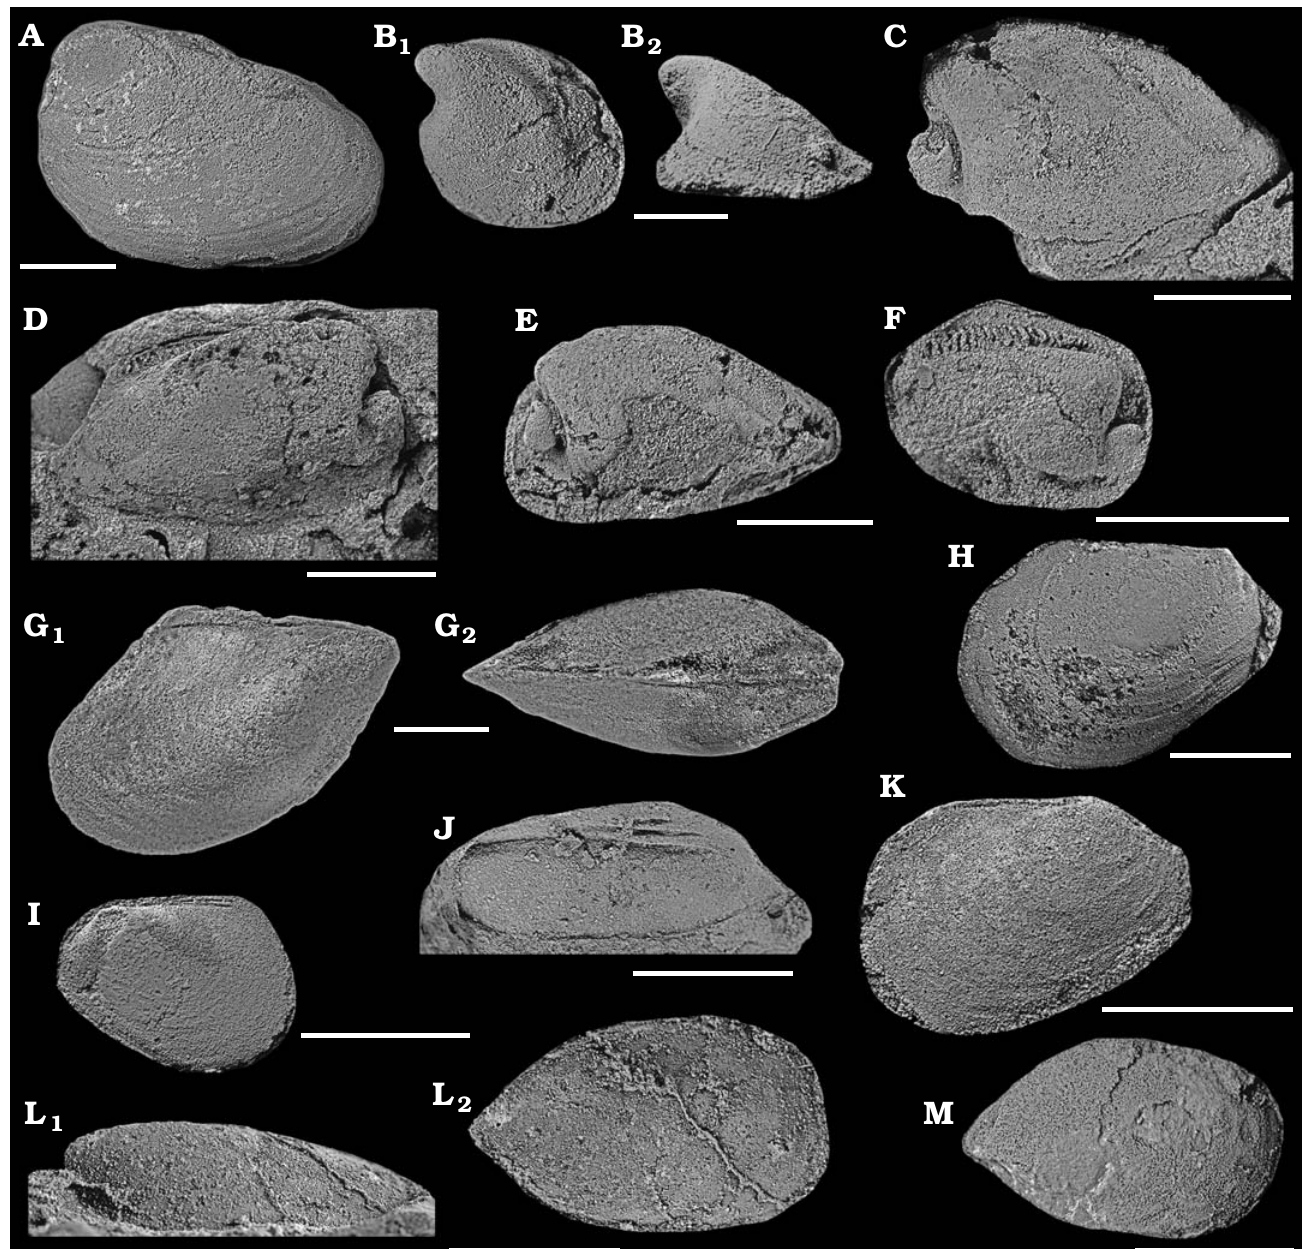
Fig. 11. Nucularcid and pteriomorphian bivalves from the Stairway Sandstone, Middle Ordovician, Australia. Internal moulds (B–K) and latex casts of ex- ternal moulds (A, L, M). A . Sthenodonta sp. B (CPC 41468) from Petermann Creek, left-lateral view showing well marked growth lines. B . Johnmartinia cordata Pojeta and Gilbert-Tomlinson, 1977 (CPC 41469) from Areyonga Gorge; left-lateral view with dorsal border (B 1 ), anterior view showing the pointy beak (B 2 ). C–F . Nuculites wattii Tate, 1896 from Areyonga Gorge. C–E . Specimens in left (C, E) and right-lateral (D) dorsal views, showing well-defined anterior myophoric buttress, D additionally shows dorsal teeth ( C , CPC 41470; D , CPC 41472; E , CPC 41472). F . Right-lateral view of fragmentary specimen with chevron shaped posterior teeth pointing anteriorly (CPC 41473). G . Cyrtodonta carberryi Pojeta and Gilbert-Tomlinson, 1977 (CPC 41474) from Areyonga Gorge; in right-lateral view with growth lines and at least one dorsal lateral tooth (G 1 ), dorsal view illustrating the height of shell profile (G 2 ). H–K . Cyrtodonta staffordae Pojeta and Gilbert-Tomlinson, 1977 from Petermann Creek (H – I, K) and Areyonga Gorge (J). H . Specimen in right-lateral view showing distinct growth lines (CPC 41475). I . Specimen in left-lateral view with three posterior lateral teeth (CPC 41476). J . Fragmentary posterior margin with duplivincular ligament and indications of three posterior lateral teeth (CPC 41478). K . Specimen in right-lateral view with a posterior lateral tooth (CPC 41477). L , M . Cyrtodonta sp. B. L . Anterior (L 1 ) and left-lateral (L 2 ) views of sub-ovate shell-profile (CPC 41479) from Petermann Creek. M . Sub-ovate shell-profile with growth lines (CPC 41480) from Areyonga Gorge. Scale bars 10